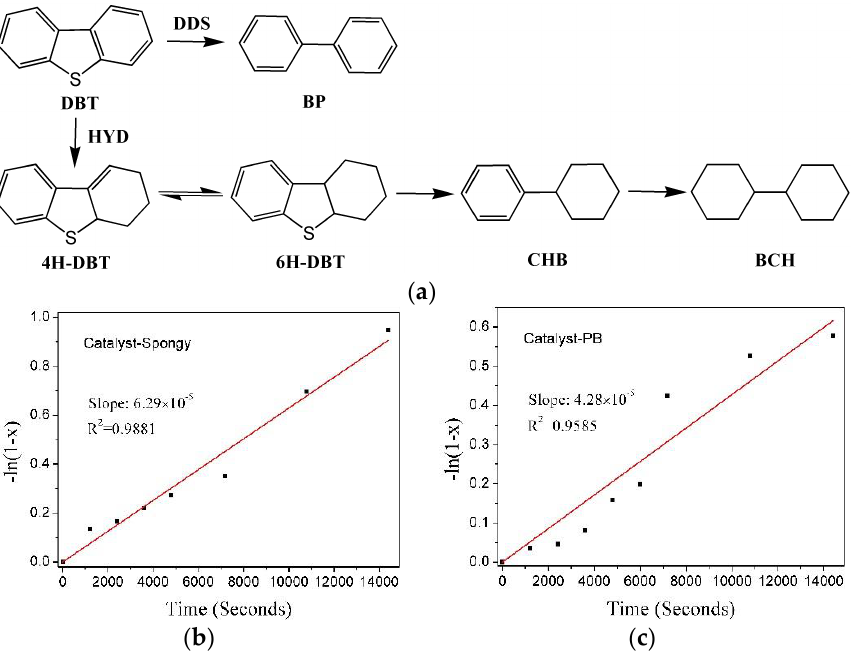
Figure 9. ( a ) The HDS network of DBT over hydrotreating catalysts. DBT (dibenzothiophene), BP (biphenyl), CHB (cyclohexylbenzene), BCH (bicyclohexyl), 4H-DBT (tetrahydrodibenzothiophene), 6H-DBT (hexahydrodibenzothiophene). Linear regression fit of −ln(1 − x) against time plots for ( b ) Catalyst- Spongy-S and ( c ) Catalyst-PB-S when the conversion of DBT is below 40%.